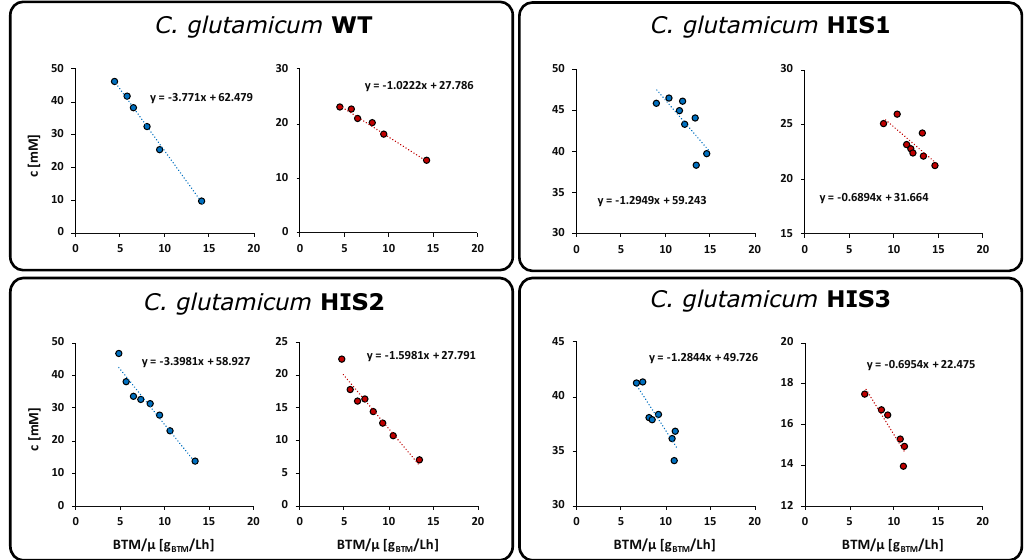
Figure 3. Determination of glucose (blue) and ribose (red) uptake rates. Uptake rates were calculated by linear regression on the basis of three independently performed experiments ( n =